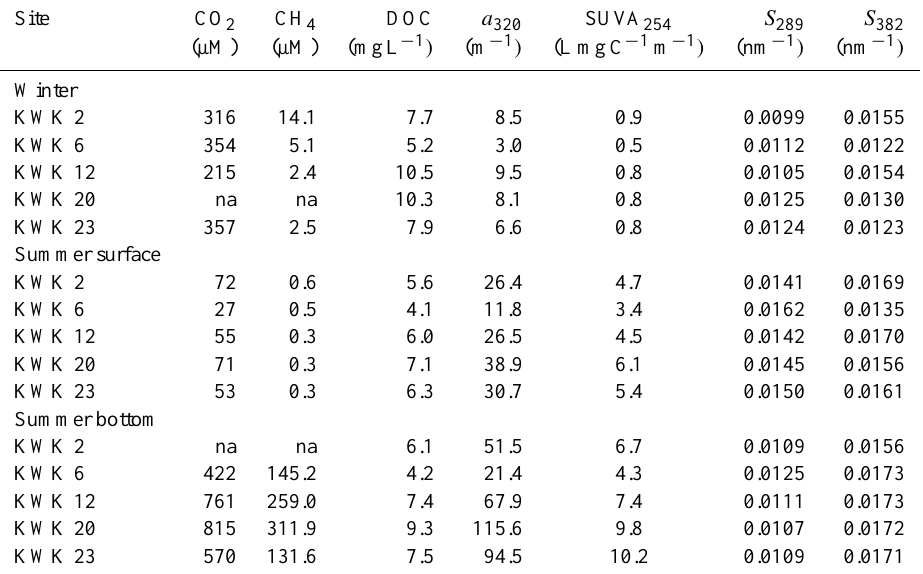
Table 2. Concentrations of carbon dioxide (CO 2 ) , methane (CH 4 ) , and dissolved organic carbon (DOC), and dissolved organic matter (DOM) optical properties, including absorption coefficient of DOM at 320nm ( a 320 ) , specific UV-absorbance index (SUVA 254 ) , and absorption spectral slopes at 289nm ( S 289 ) and 382nm ( S 382 ) , of subarctic pond water sampled in late winter and during summer at the surface and bottom of the water column.